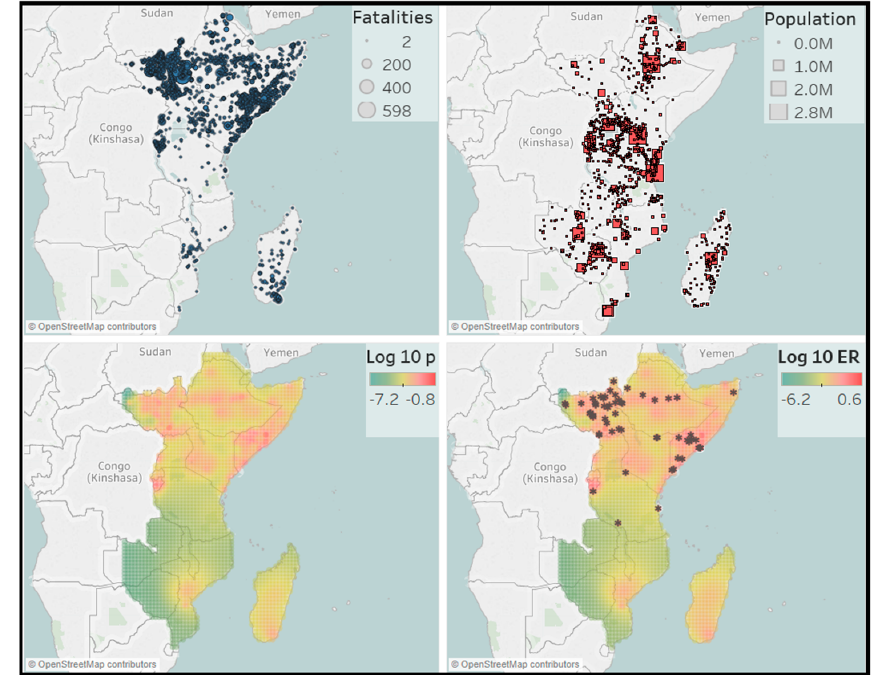
Figure 14. Forecasts for East Africa. Top left: event catalog 2012–2016. Top right: City map with cities with 1000+ population. Bottom left: spatial background distribution estimated from the data from 2012–2016. Bottom right: forecast for the expected number of events with 𝑀 ≥ 4 in each cell in the year 2017, together with the locations of the actual conflicts that have taken place with 𝑀 ≥ 4 .